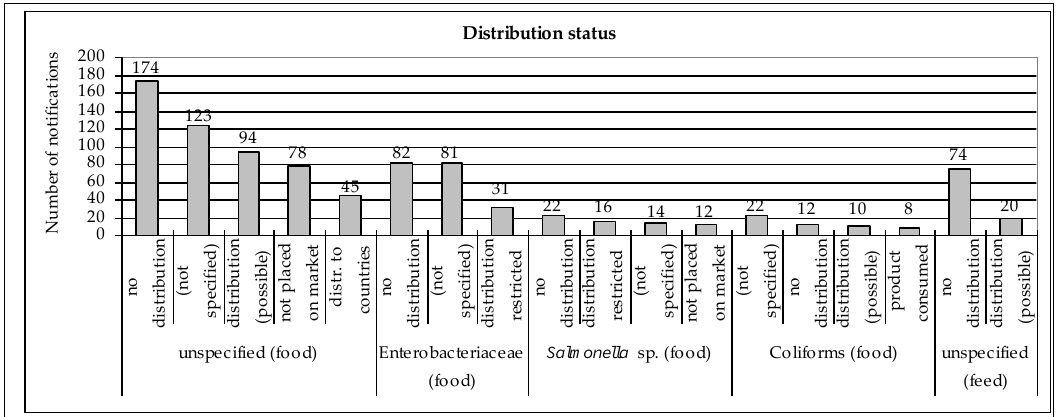
distr. to countries—distribution to other member countries; distribution (possible)—distribution on the market (possible); distribution restricted—distribution restricted to notifying country; not placed on market—product not (yet) placed on the market; product consumed—product already consumed